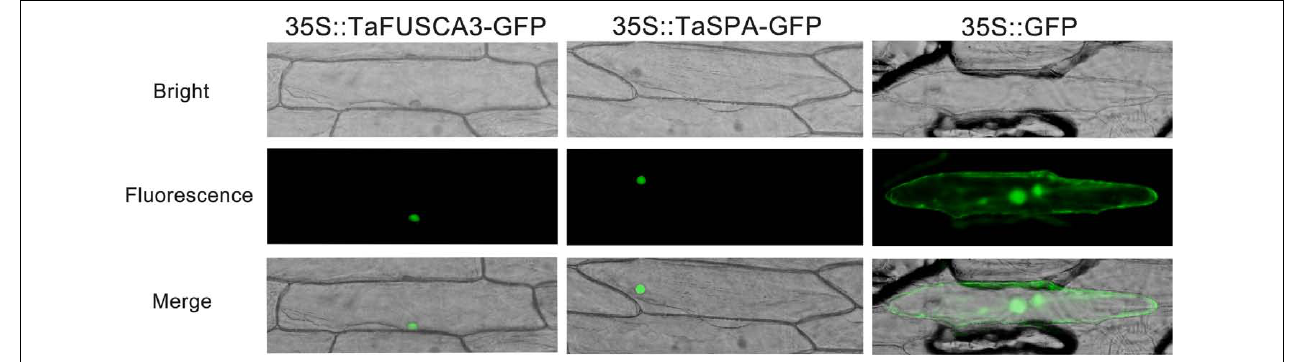
FIGURE 2 | Subcellular localizations of TaFUSCA3 and TaSPA. The fusion proteins 35S::FUSCA3-GFP (pCAMBIA1303- FUSCA3-GFP ), 35S::SPA-GFP (pCAMBIA1303- SPA-GFP ), and 35S::GFP (pCAMBIA1303- GFP , control) were transiently expressed in onion epidermal cells and visualized with fluorescence microscopy 24 h after bombardment.